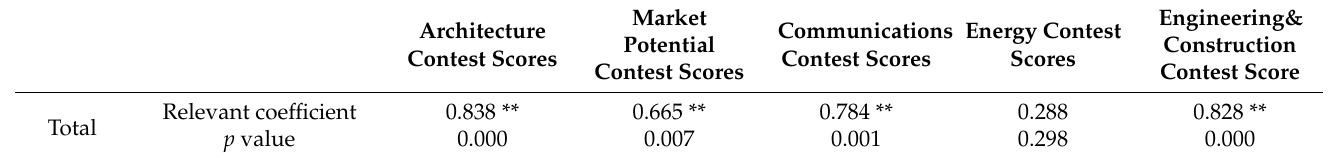
Table 10. Correlation analysis of the score of 5 objective items with the total score in SDC2021. Interactive Energy Self- Indoor Renewable Home Life Experience Sufficiency Environment Heating&Cooling Relevant coefficient 0.771 ** 0.836 ** 0.847 Total